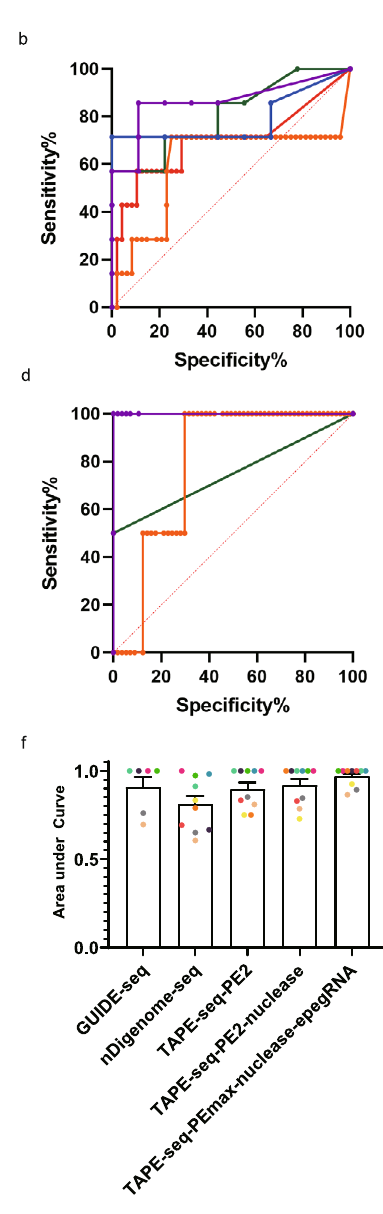
Fig. 5 | ROC curve analysis. a – e ROC curves for GUIDE-seq (red), nDigenome-seq (orange),andTAPE-sequsingPE2(green),PE2-nuclease(blue),andPEmax-nuclease withepegRNAs(purple)forthe a HEK4 (+2GtoT), b HEK4 (+3TAAins), c HBB (+4A to T), d DNMT1 (+6G to C), and e HEK3 (+1 CTT ins) pegRNAs. f Area under ROC